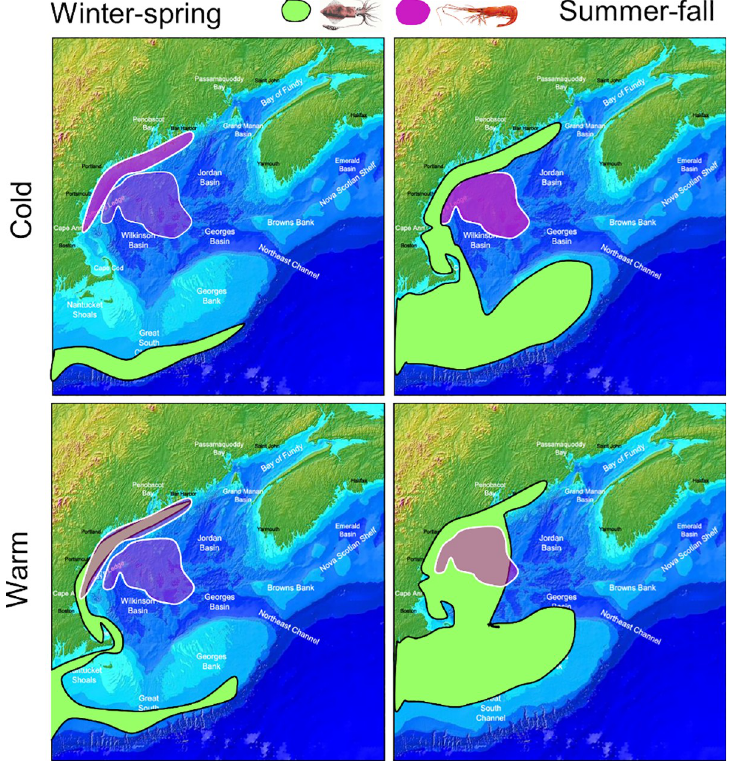
Fig 13. Conceptual model of seasonal distribution patterns of northern shrimp and longfin squid. (A.) cold years, (B.) warm years.